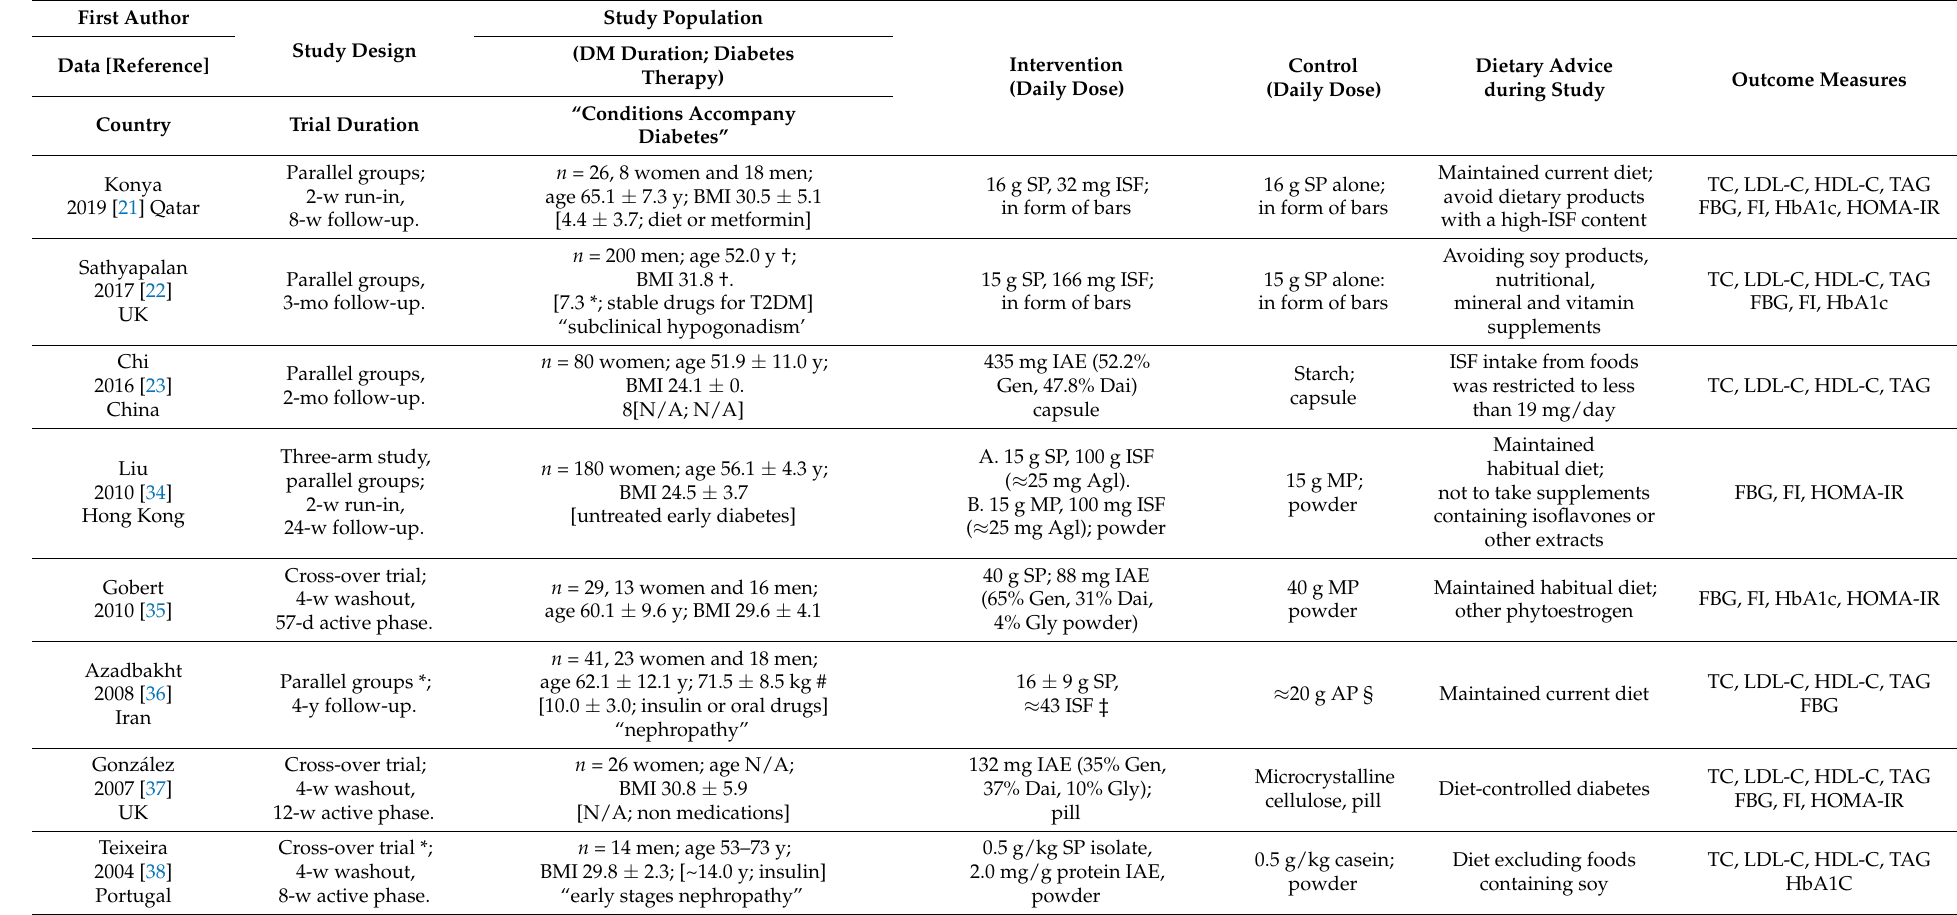
Table 1. Characteristics of selected randomized clinical studies assessing effect of soy isoflavones on glycemic control and lipid profile in type 2